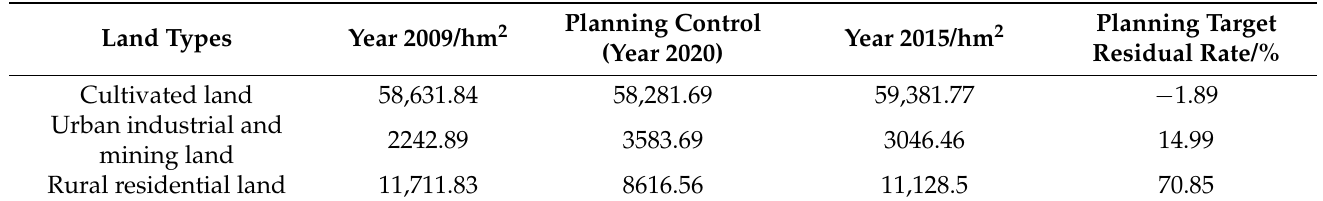
Table 4. Residual situation of control objectives of general land-use planning in Rongchang